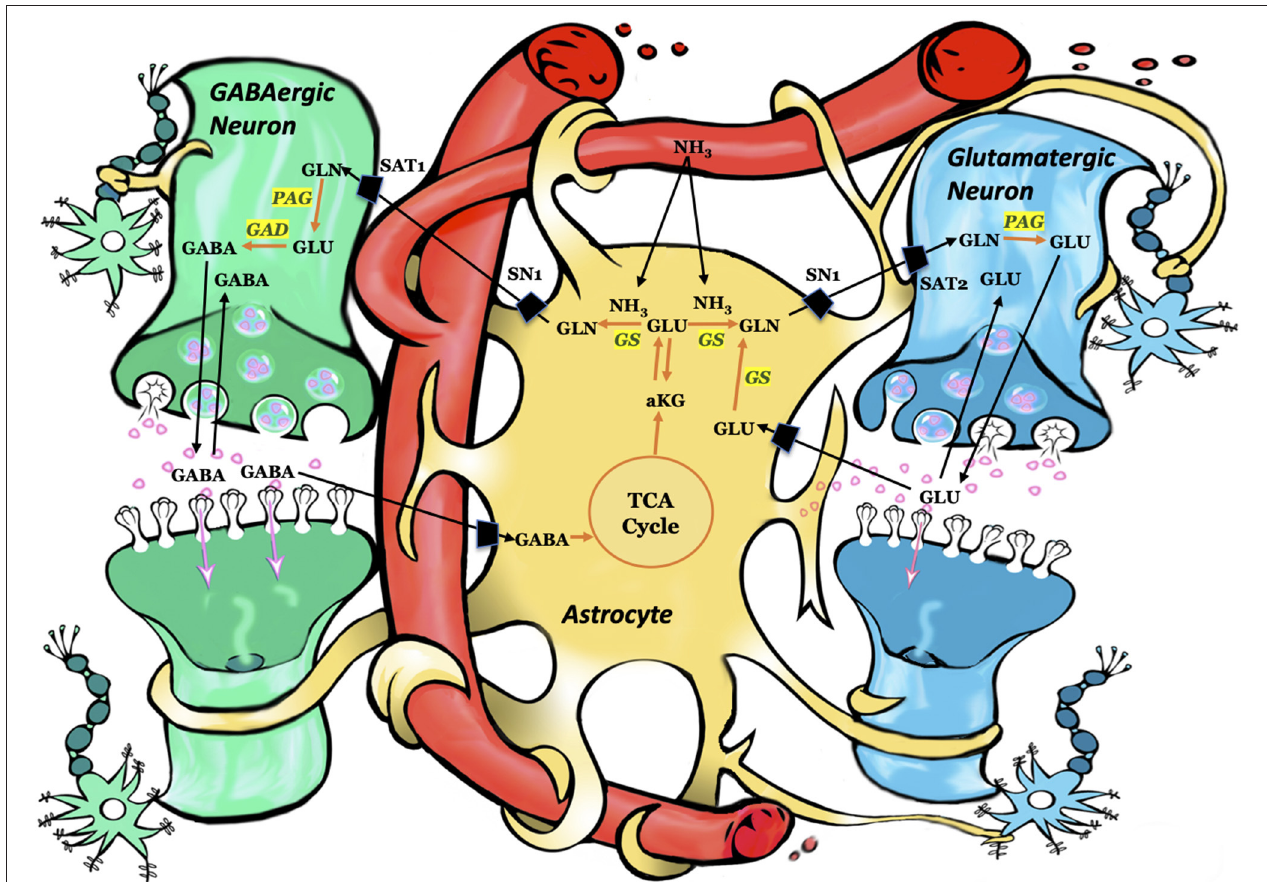
FIGURE 1 | Schematic representation of key pathways involving astrocytes, glutamatergic neurons, and GABAergic neurons. Each arrow signifies several reactions. Using ammonia, glutamine synthetase converts glutamate to glutamine. Subsequently, glutamine is taken up by the adjacent neurons and converted to glutamate or GABA. Astrocytes take up the synaptic glutamate (glutamine–glutamate cycle) or GABA (glutamine–glutamate–GABA cycle) and converts these neurotransmitters to glutamine via glutamine synthetase. GLN, glutamine; GLU, glutamate; GABA, gamma-aminobutyric acid; aKG, alpha ketoglutarate; TCA, tricarboxylic acid cycle; GS, glutamine synthetase; PAG, phosphate-activated glutaminase; GAD, glutamic acid decarboxylase; SN1, system N transporter 1; SAT1, system A transporter and SAT2, system A transporter 2. Figure adapted with permission from